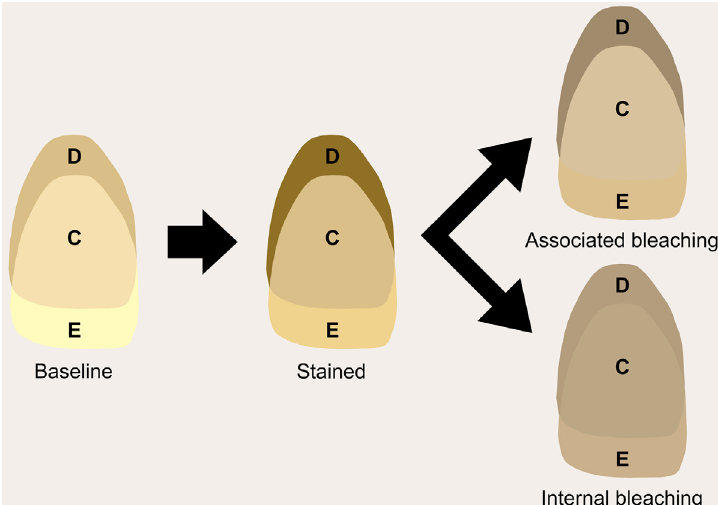
Figure 3- Illustrative image of color changes after staining and bleaching procedures. Substrates and background colors were painted using L*, a*, and b* parameters. D – dentin, C, combined, and E – enamel